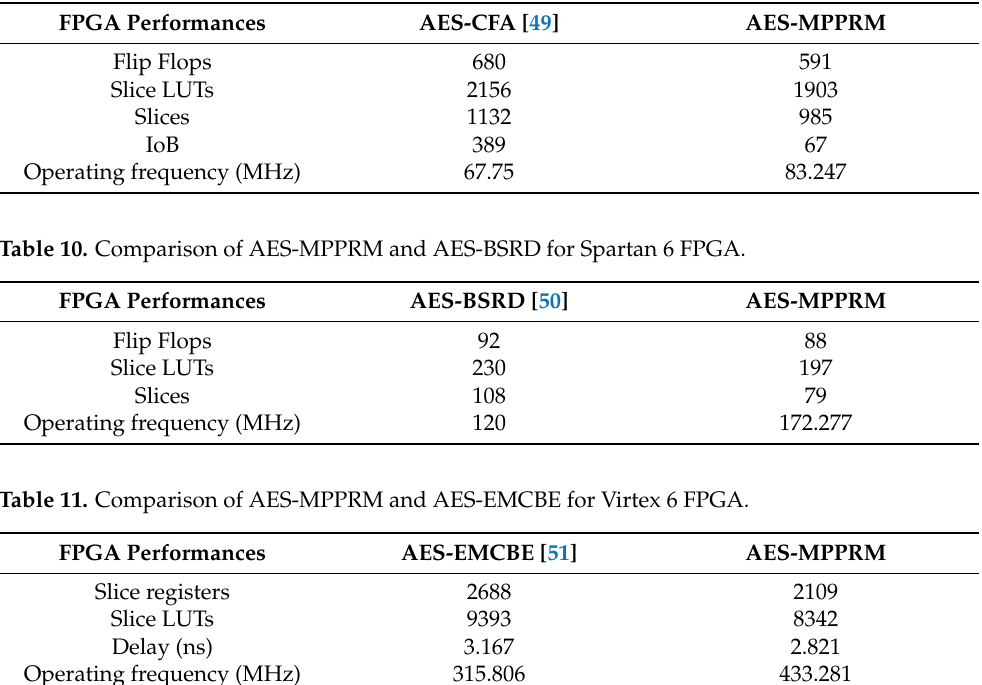
Table 9. Comparison of AES-MPPRM and AES-CFA for Spartan 3 FPGA.